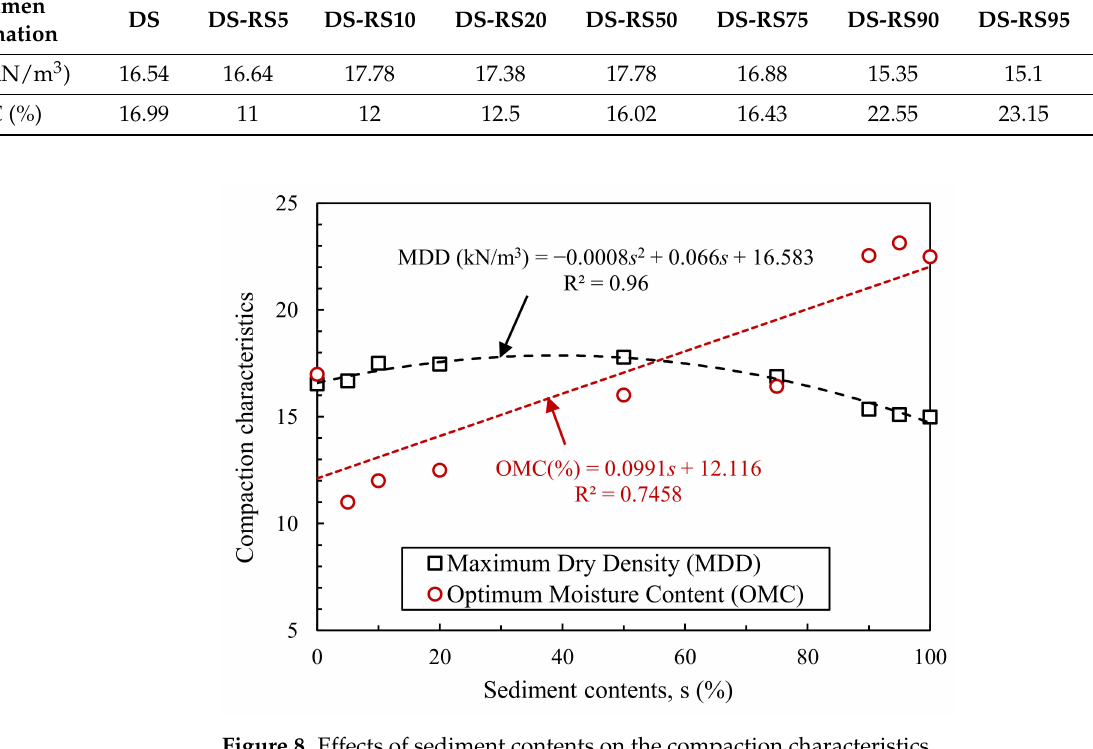
Figure 8. Effects of sediment contents on the compaction